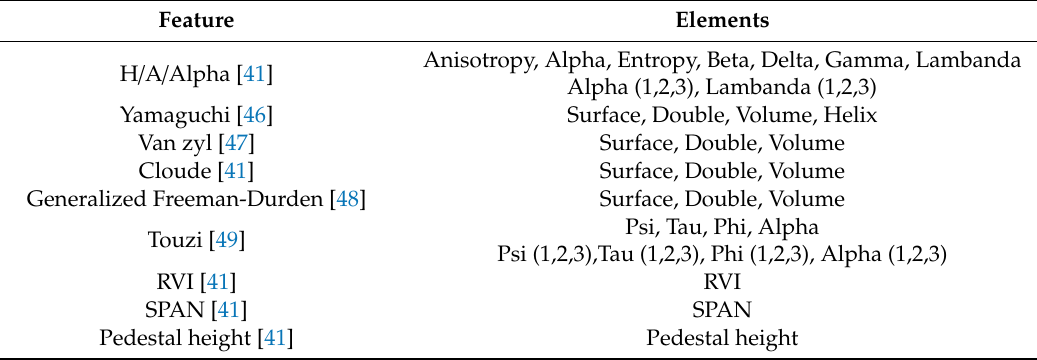
Table 4. ALOS-2 polarimeteric